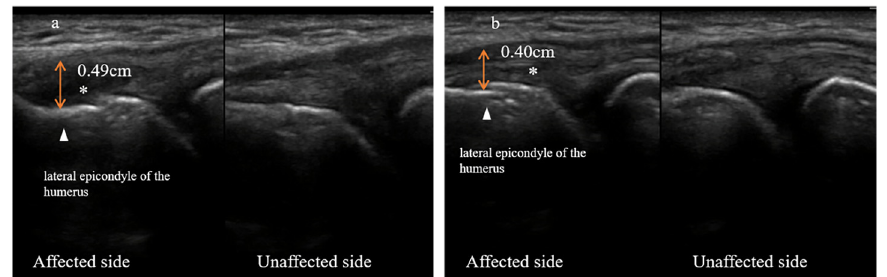
Figure 4. Ultrasound images of the lateral side of the left elbow of a patient with refractory lateral epicondylitis (case one) at baseline ( a ) and four weeks from the baseline ( b ). Bilateral comparison of the common extensor tendons: left elbow (affected side) and right elbow (unaffected side). The triangle points to the lateral epicondyle of the humerus. The asterisk marks the anechoic area formed by the extensor tendon tear. Double-arrowhead solid lines show the thickening of the extensor tendons.